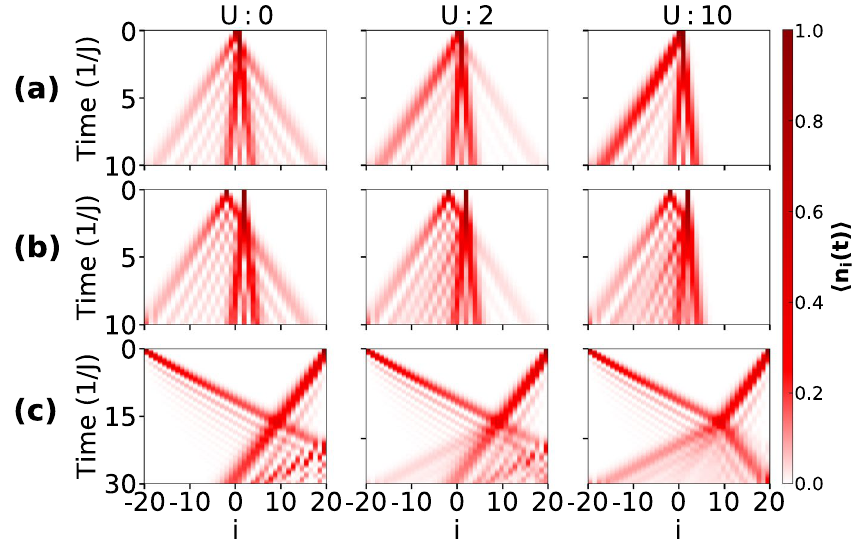
Figure 7. Shows the QWs for different initial states and different values of U . Here ( a – c ) depict the total density (normalized) evolution for the three initial states Eqs. (11), (12) and (13) respectively. For results depicted in ( a ) and ( b ) δ = 0.2 and for ( c ) δ = 0.4 has been considered.